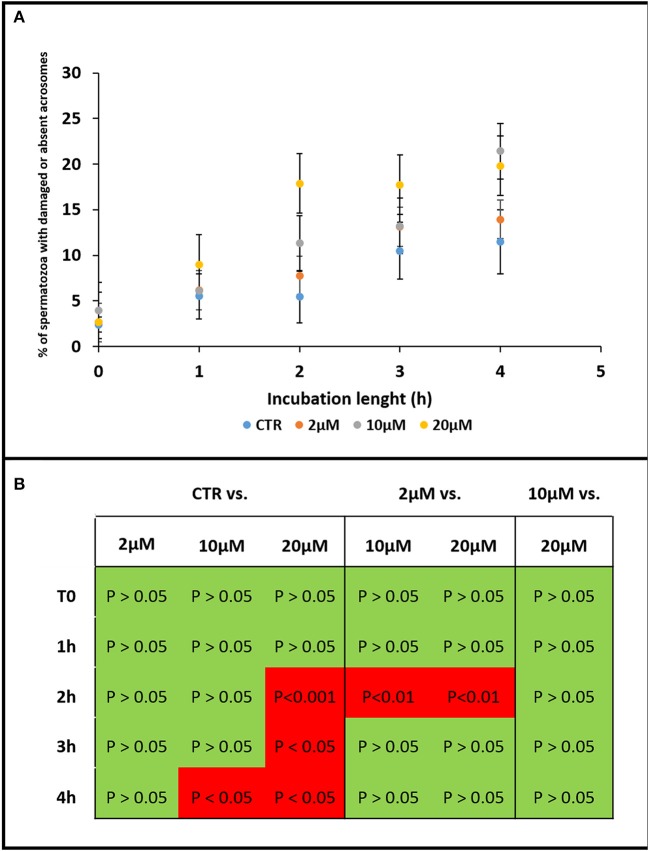
Graph showing the effect of Aminopurvalanol A on acrosome integrity. The effects of Aminopurvalanol A at different concentration and incubation times on the percentage of spermatozoa with absent or damaged acrosome were shown (A). The statistically relevant differences are reported (B). The data are reported as mean±standard deviation, and the comparisons were carried out with ANOVA two ways, followed by Tukey's post-hoc test.